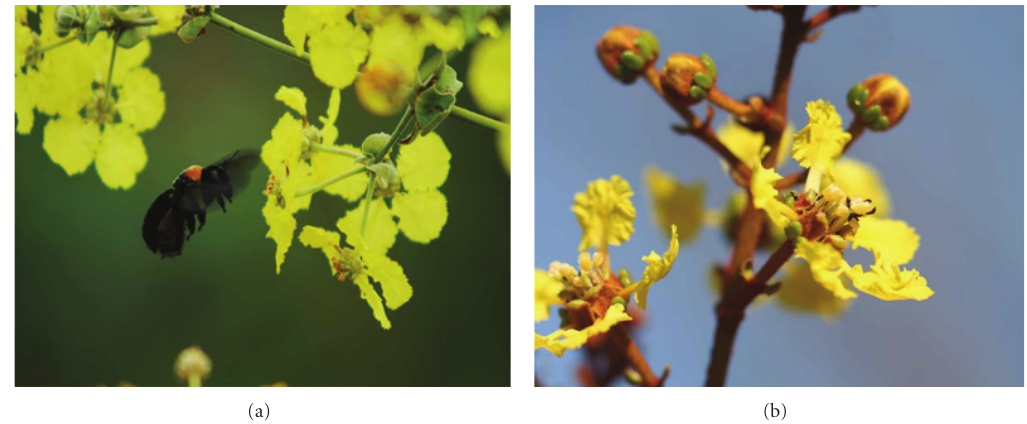
Figure 1: The Malpighiaceae ( Peixotoa tomentosa ) has its flowers visited by (a) the pollinator bee ( Centris ( Ptilotopus ), Apidae) and (b) also (like in Banisteriopsis laevifolia) by the small black thrips ( Heterothrips peixotoa , Heterothripidae) that infest and destroy its stamens and